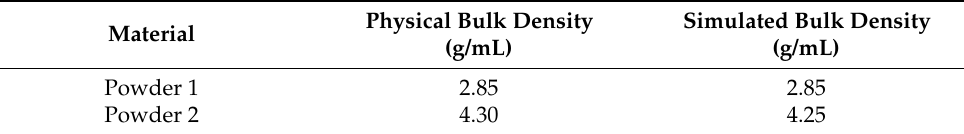
Figure 5. Experimental and basic flow energies at 100 mm/s blade-tip speed for ( a ) free-flowing powder and ( b ) cohesive powder. Table 1. Physical bulk density and matched simulated results.